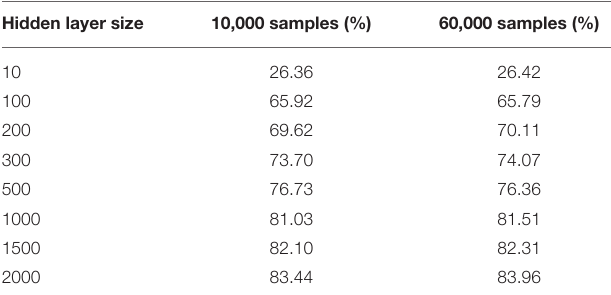
TABLE 1 | Accuracy for the N-MNIST dataset after 10,000 and 60,000 training samples for different hidden layer